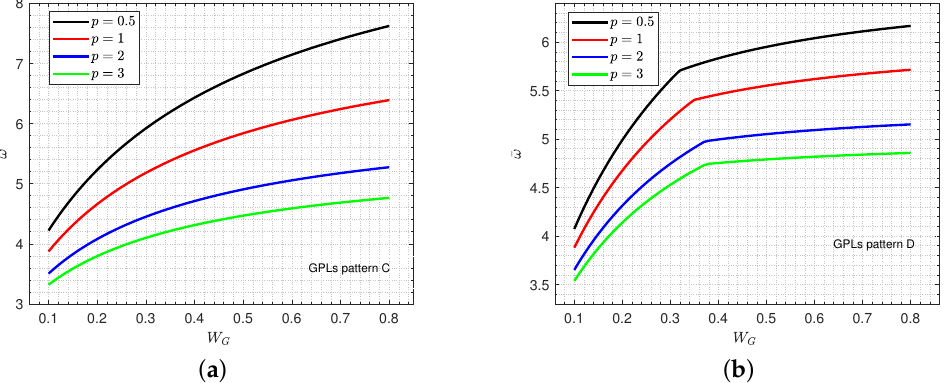
Figure 6. Wave frequency ¯ ω (THz) of the FG GPLs-reinforced sandwich nanocomposite piezoelectro- magnetic plate with a honeycomb core versus the graphene weight fraction W G for various values of the power law index p and for various GPLs patterns: ( a ) pattern C and ( b ) pattern D.